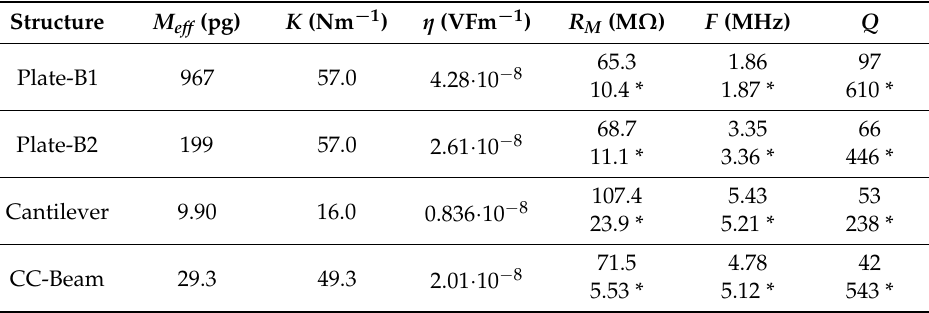
Table 2. Resonator parameters obtained from the theoretical expressions. The spring constant value does not consider the spring-softening effect, and the motional resistance and coupling are computed at 50 V biasing voltage except for Plate-B1 is computed at 40 V biasing. The quality factor and resonance frequency are obtained from experimental data presented below, given the same biasing voltage. * Refers to vacuum (1 µ Torr).